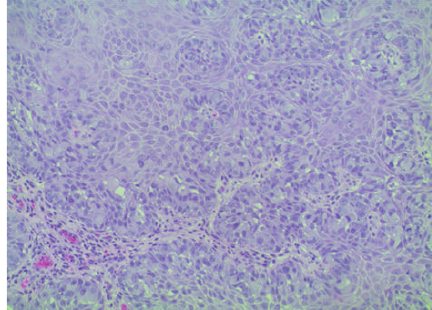
Figure 3: Histological image (high power) of epidermis infiltrated by suprabasal small nests and single epithelial cells with abundant vacuolated cytoplasm highlighted by mucicarmine special